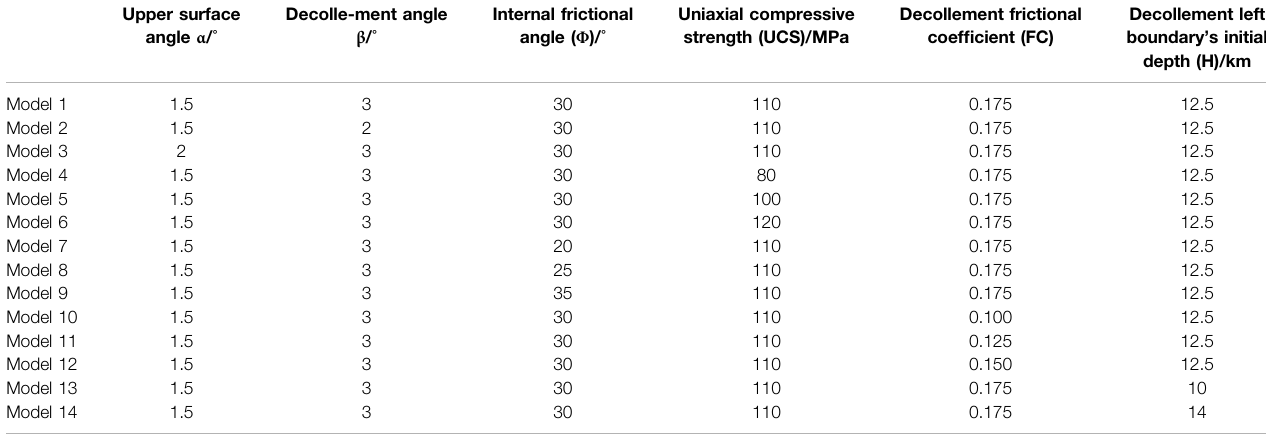
TABLE2| Modelparametersofour14elastic-plastic fi nite-elementmodelsforfold-and-thrust-beltsevolutioninJiudongbasin.Variables α and β areinclinationanglesoftop and bottom surfaces of wedge, respectively; φ and UCS are plasticity parameters; H is depth of decollement at left boundary in initial (undeformed) con fi guration of wedge, and FC decollement friction coef fi cient. Wedge uncompressed mass density is ρ (cid:1) 2,500 kg/m 3 , Young ’ s modulus E (cid:1) 6 × 10 ^ 4 MPa and Poisson ’ s ratio ] (cid:1) 0.25 (compressible), for all models.